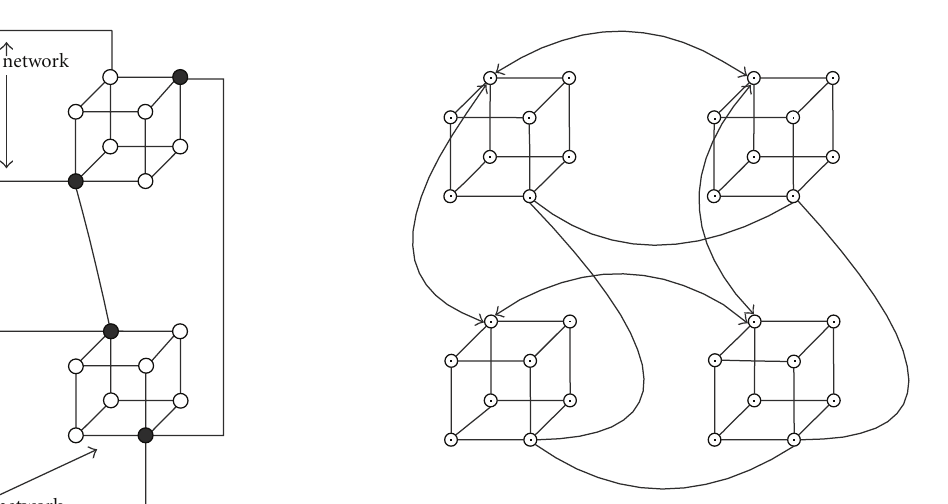
Figure 3: A HIN based on Hypercubes